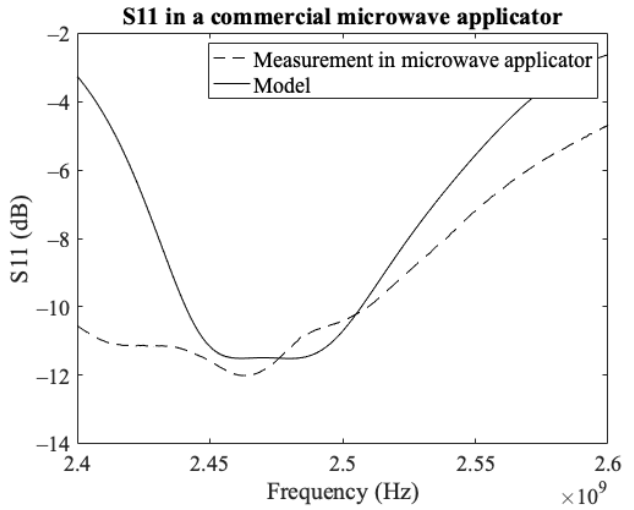
Figure 8. Comparison between the S11 parameters of the measurement with the antenna feeding a commercial microwave oven and the model. Table 2. Power measurements of the 2-liter test.